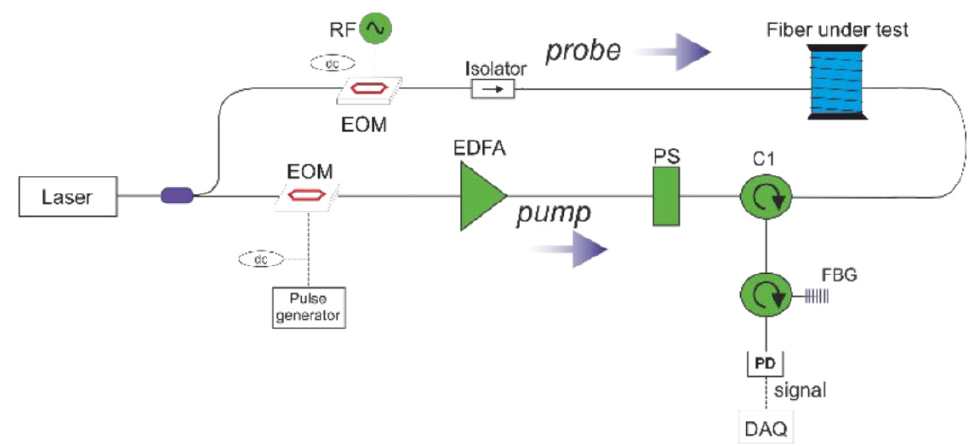
Figure 16. Experimental setup for distributed measurement of temperature in optical fibers. EOM: electro-opticmodulator; PS: polarization scrambler; EDFA: erbium-doped fiber amplifier; PD: photodetector; FBG: fiber Bragg grating [159] .